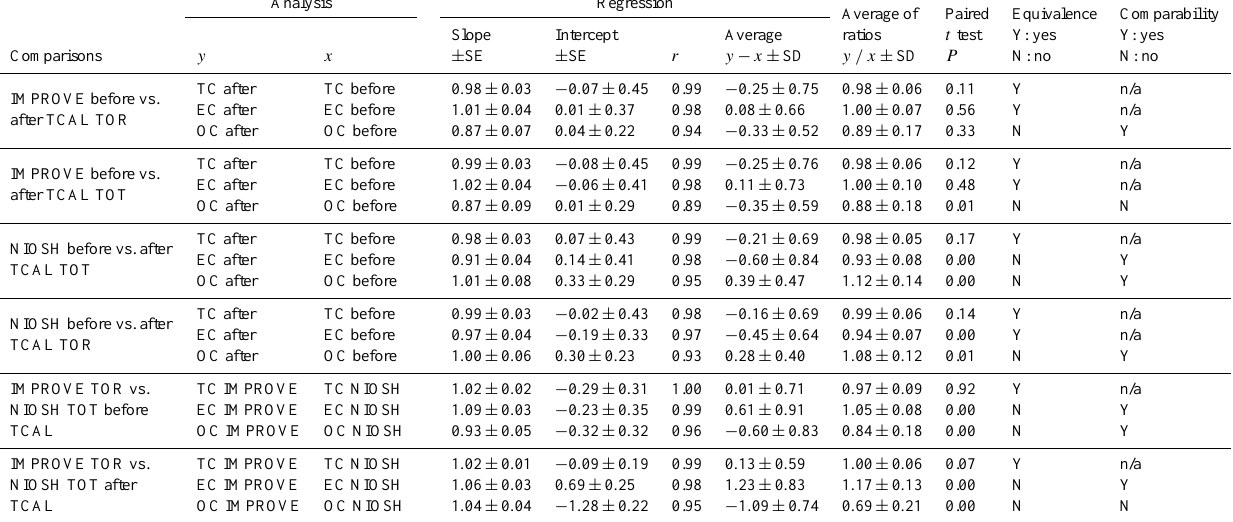
Table 4. Comparability statistics results for NIOSH and IMPROVE TOR and TOT carbon fractions before and after temperature calibration ∗ . Analysis Regression Average of Paired Equivalence Comparability Slope Intercept Average